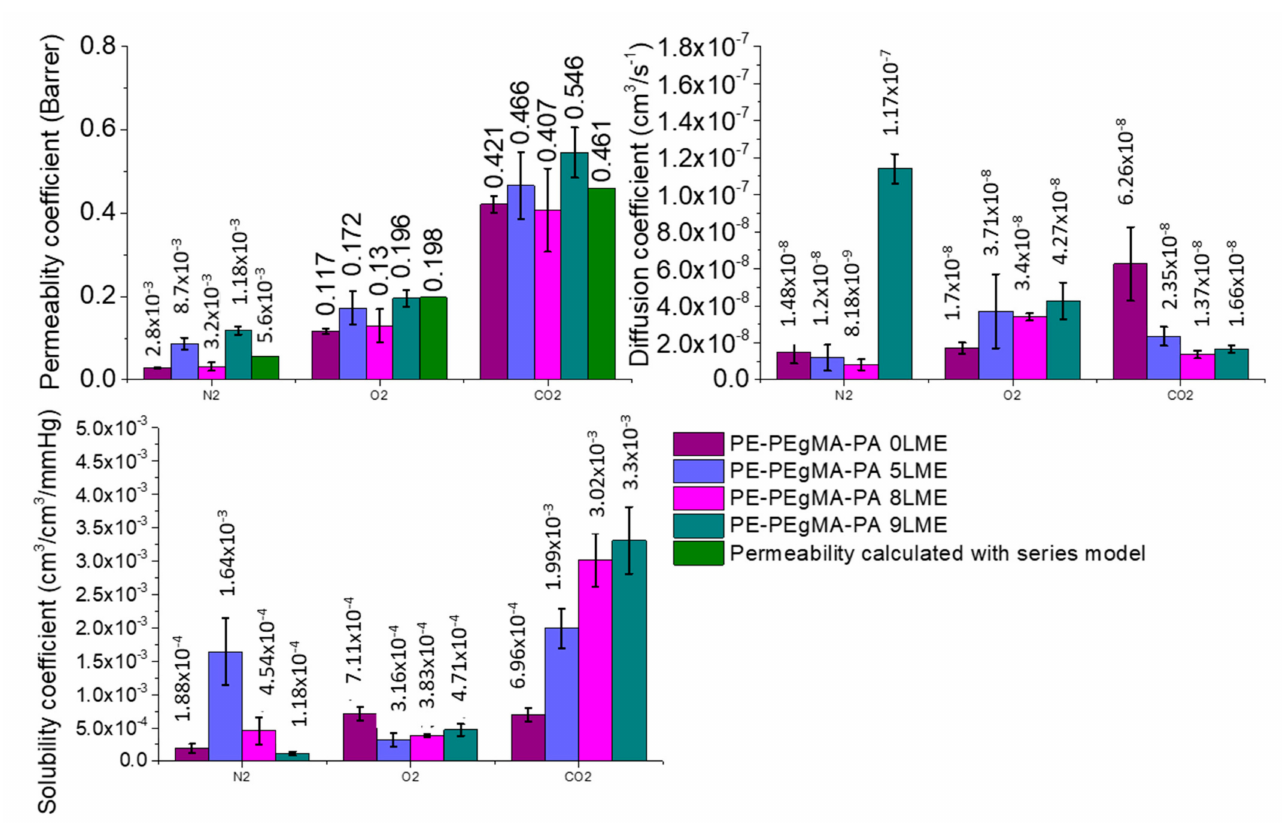
Figure 6. Transports properties of multilayer films compared to predicted values given by serial